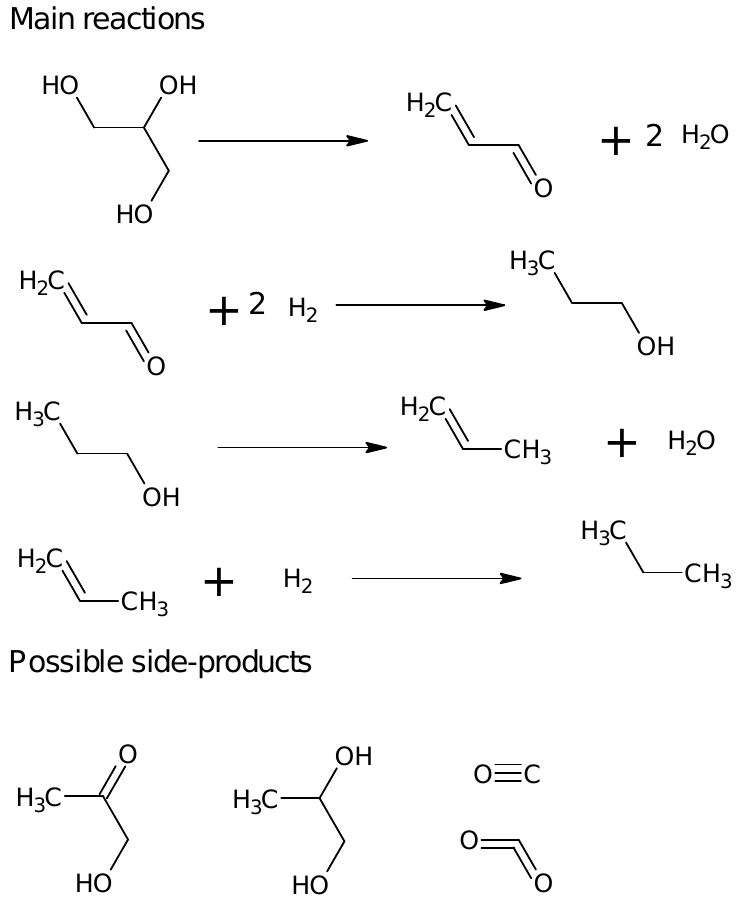
Figure 1. Reactions involved in transforming glycerol to propane and the side products acetol, propylene glycol, carbon monoxide, and carbon dioxide.